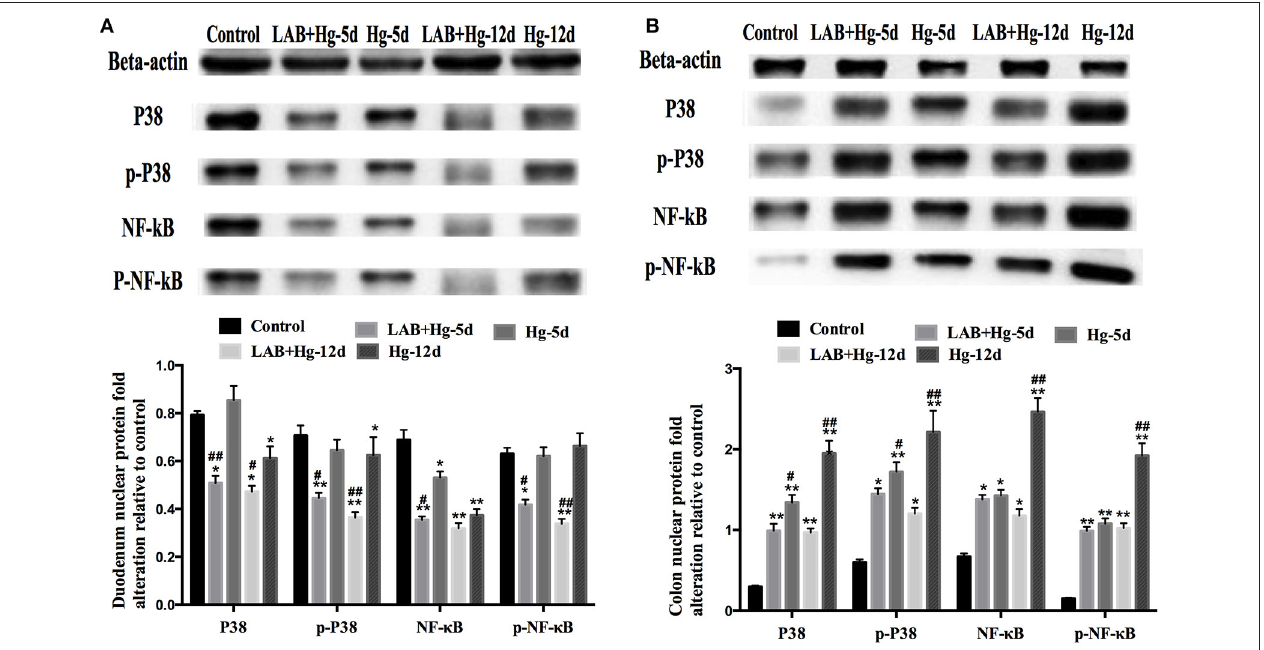
FIGURE 5 | Potential role of MAPKs in inflammation observed after supplementation of LAB on Hg-exposed tissue as assessed by western blot. (A) Relative quantity duodenum P38, p-P38, NF- κ B, and p- NF- κ B . (B) Colonic results. *and # denote p < 0.05, **and ## denote p < 0.01; Data with * and **represent comparisons to the control group; # and ## represent LAB + Hg-5d group compared to Hg-5d group, or LAB + Hg-12d group compared to Hg-12d. Results are represented as the mean ± SEM of three independent